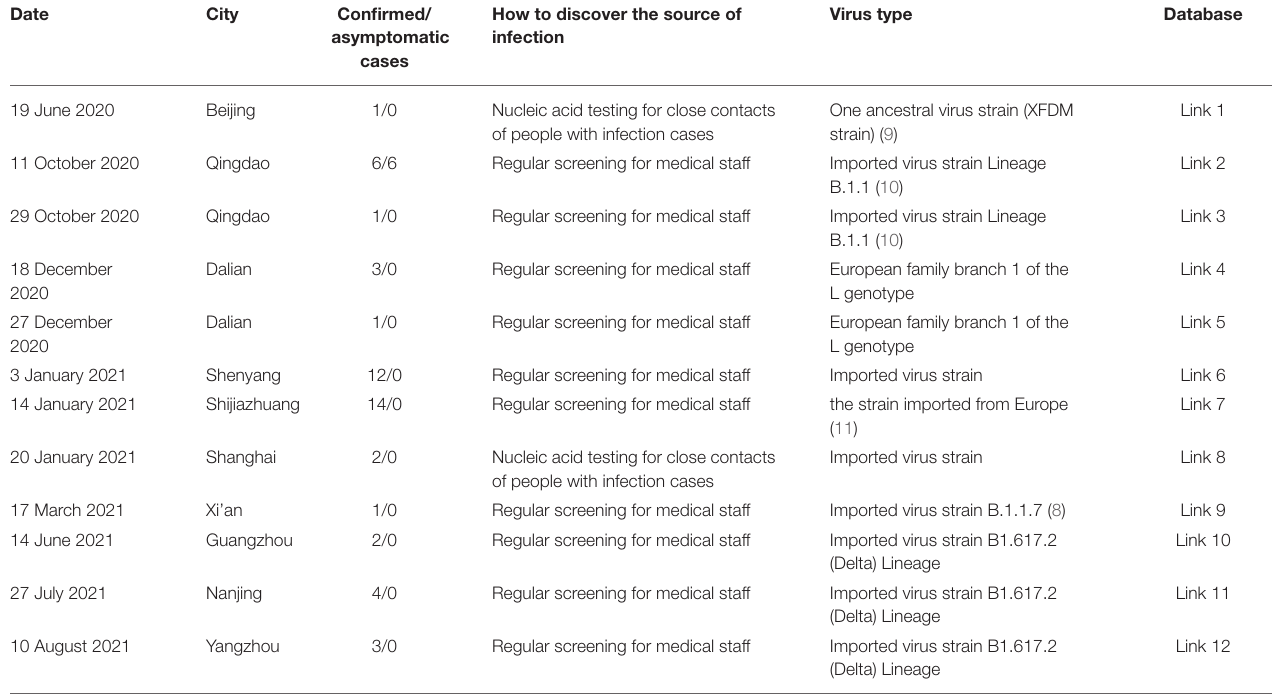
TABLE 2 | Epidemiological characteristics of sporadic nosocomial COVID-19